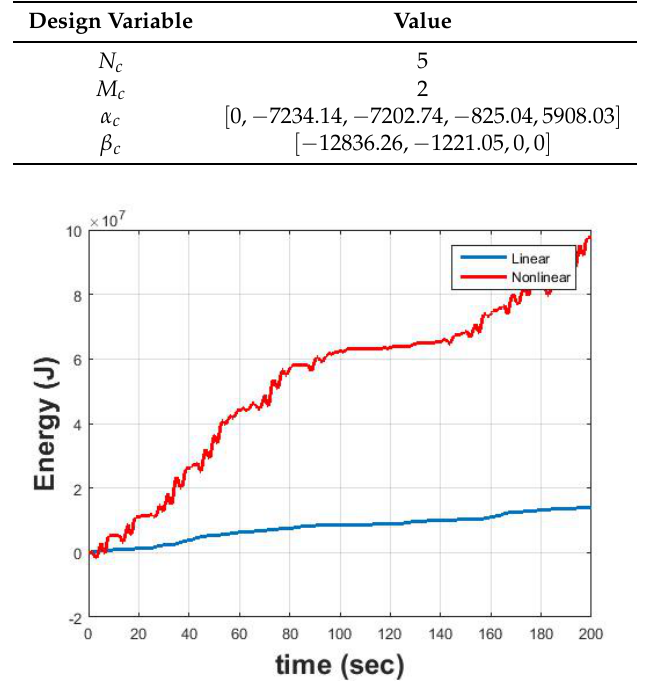
Table 2. Control parameters selected in the case of WEC in an irregular wave.